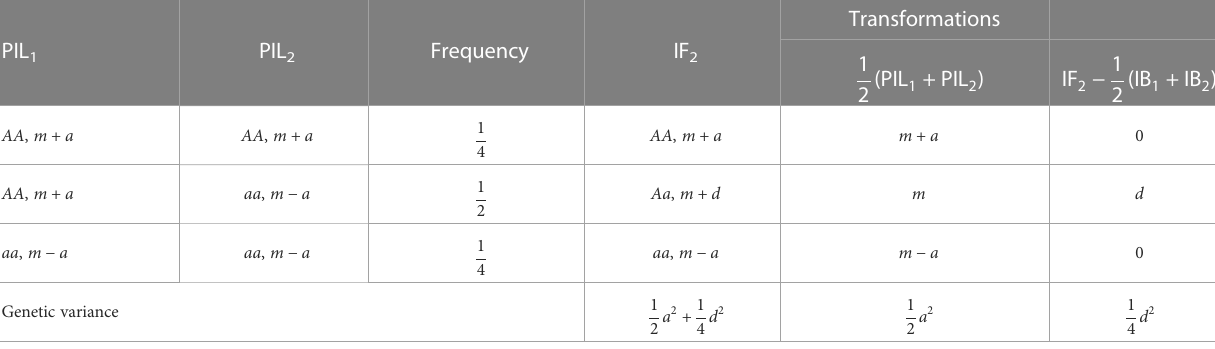
TABLE 2 Genotypes, genotypic values and genetic variances at one locus in population IF 2 , where m , a , and d are mid-parental value, additive and dominant effects,